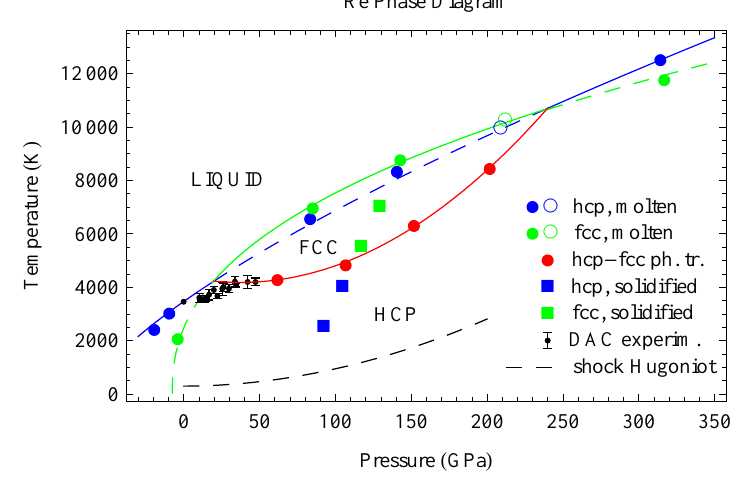
Figure 11. The phase diagram of Re based on the theoretical results of this work vs. the experimental DAC data of Ref. [6].